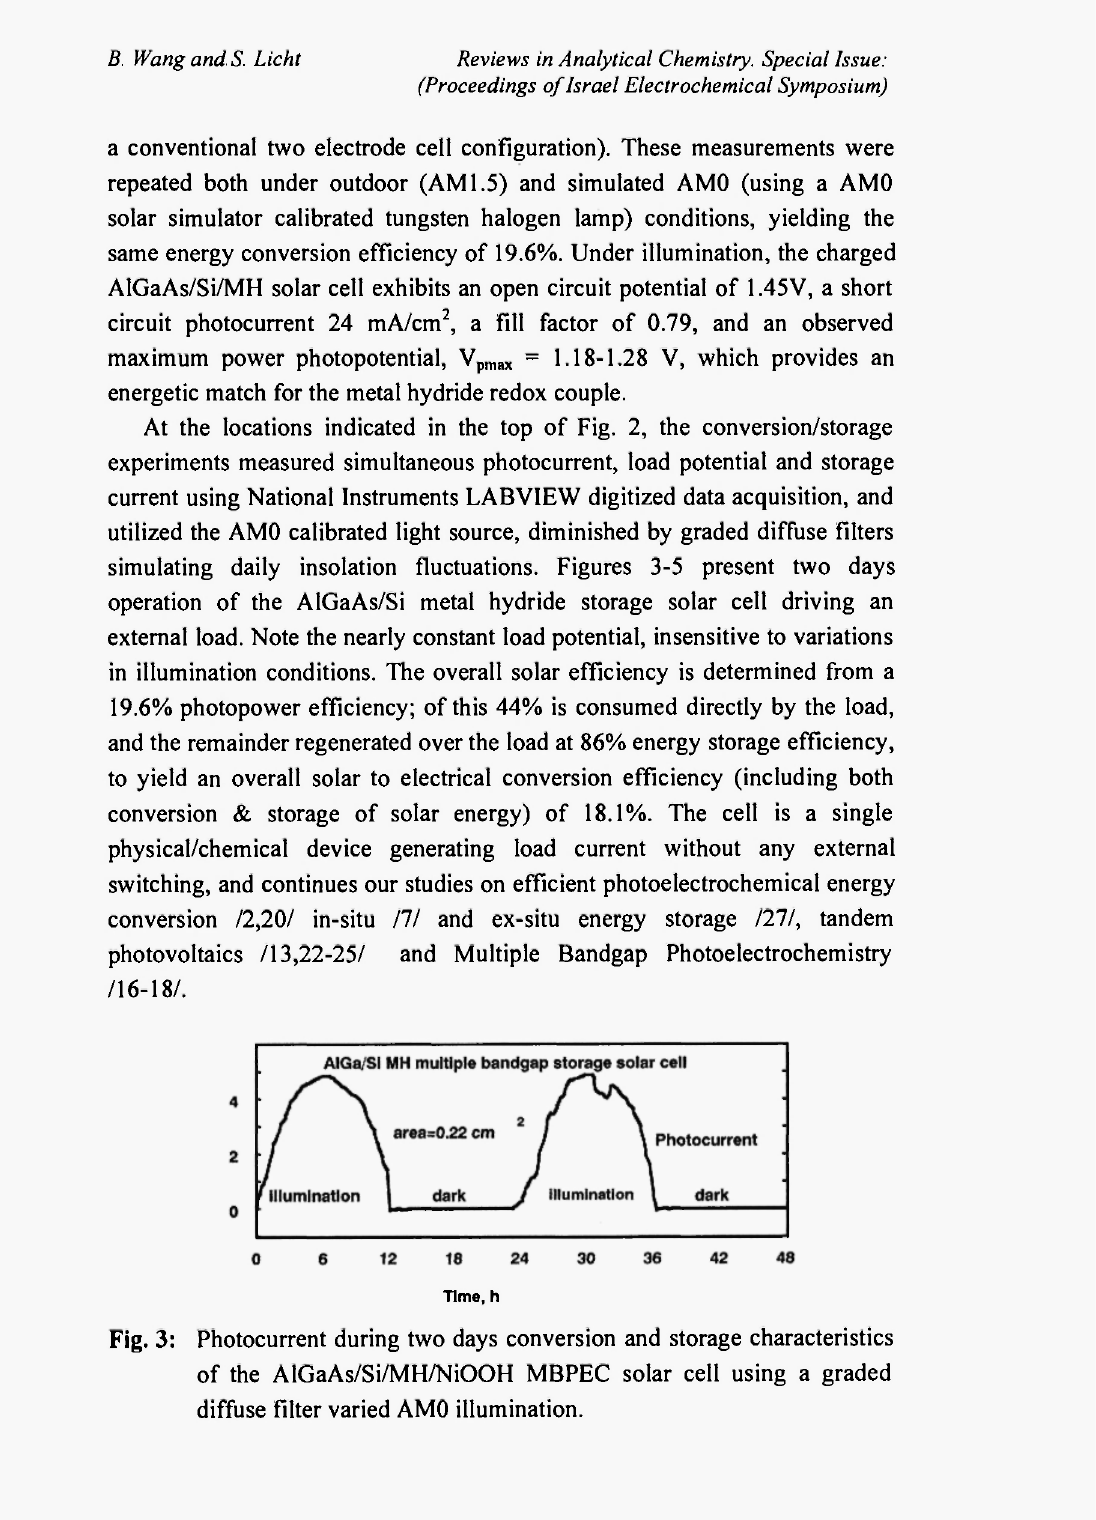
Photocurrent during two days conversion and storage characteristics of the AlGaAs/Si/MH/NiOOH MBPEC solar cell using a graded diffuse filter varied AMO